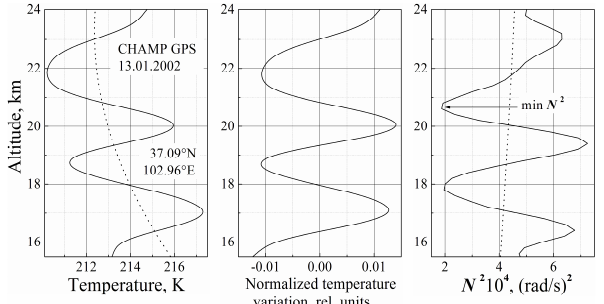
squared N 2 . The solid line (left panel) is the raw tempera- ture data, T , and the dotted line is the background temper- ature profile, T b , determined by a least-squares cubic